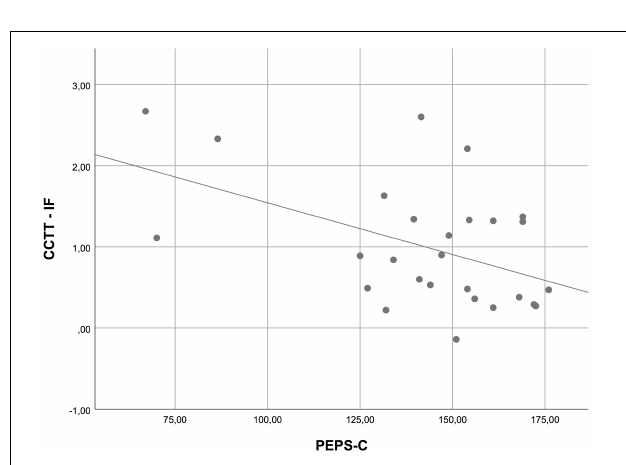
FIGURE 3 | Scatter plot displaying the correlation between PEPS-C and CCTT Interference Index (CCTT-IF).